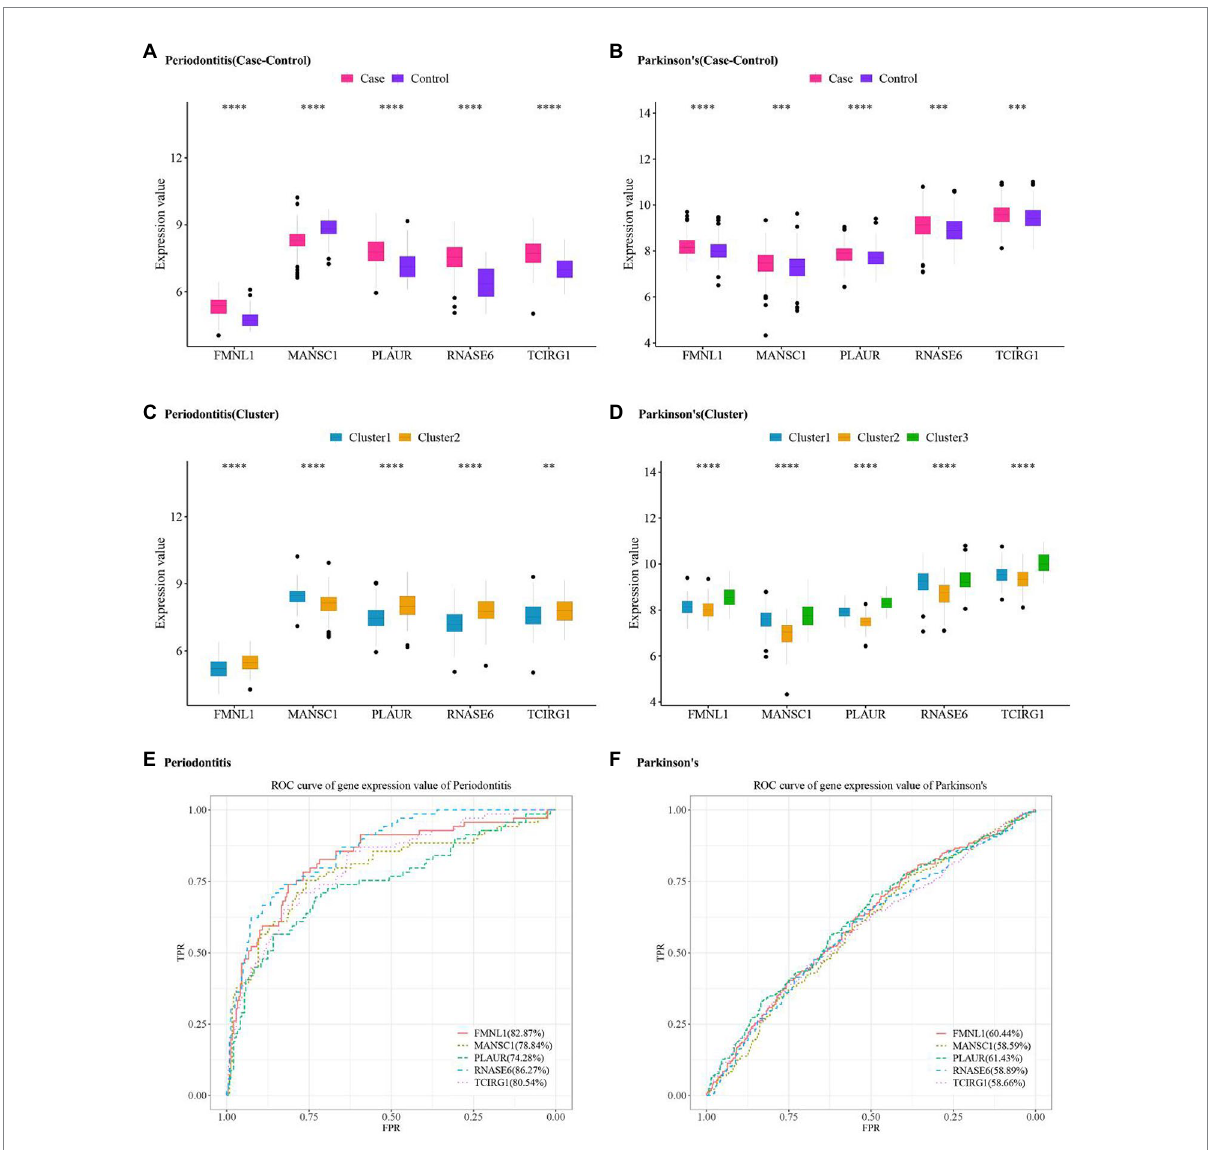
FIGURE 10 Hub cross-talk gene expression level and ROC analysis in periodontitis and Parkinson’s disease. (A,B) Hub cross-talk gene expression levels and differences between disease samples and normal samples in periodontitis and Parkinson’s disease, respectively. (C,D) Hub cross-talk gene expresses levels and differences in different clusters of periodontitis and Parkinson’s disease. The smaller the test result, the more “ * ” on the plot, and the correspondence between the p value and the “ * ” sign is ns: p > 0.05, * : p ≤ 0.05, ** : p ≤ 0.01, *** : p ≤ 0.001, **** : p ≤ 0.0001. (E,F) ROC analysis results regarding the diagnostic accuracy of hub cross-talk genes in periodontitis and Parkinson’s